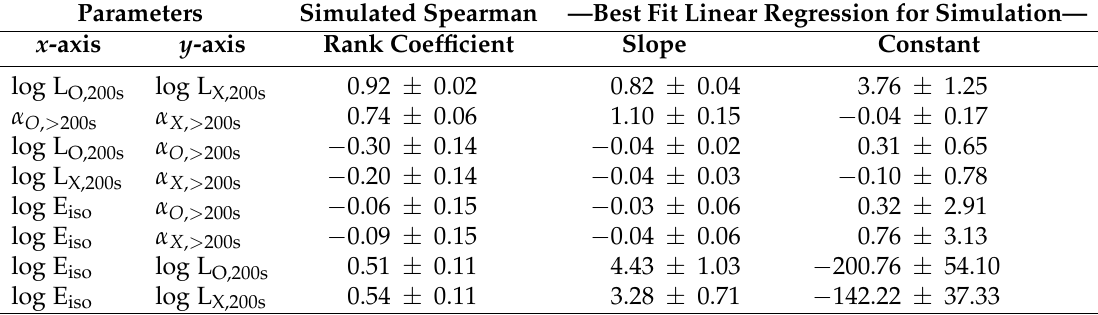
Table 2. The Spearman rank coefficient and linear regression parameters as predicted for the synchrotron model of a sample of 48 GRBs, using a Monte Carlo simulation with 10 4 trials (Table is adapted from Table 1 from